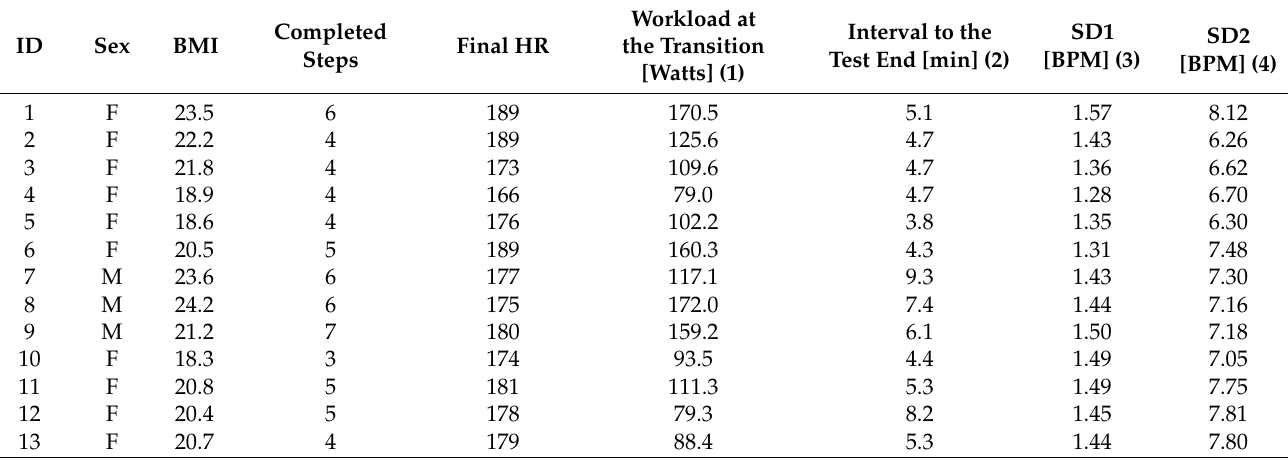
Table 4. The individual results of all participants including (1) workload at the transition estimated as an average from all approaches (IP1–IP8 ); (2) average interval from the transition to the end of stress test (IP1–IP3) ; (3) and (4) SD1 and SD2 from the Poincare respirate-rate-related analysis; all linked to demographical data (sex and BMI), the number of completed steps (fitness level equivalent), and final HR (at the end of the stress